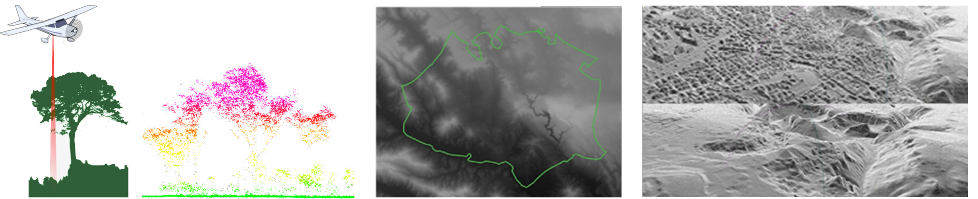
Figure 2. From left to right: LiDAR acquisition; generated point cloud; DTM raster image (gray level representing elevation); reconstructed DSM—DTM